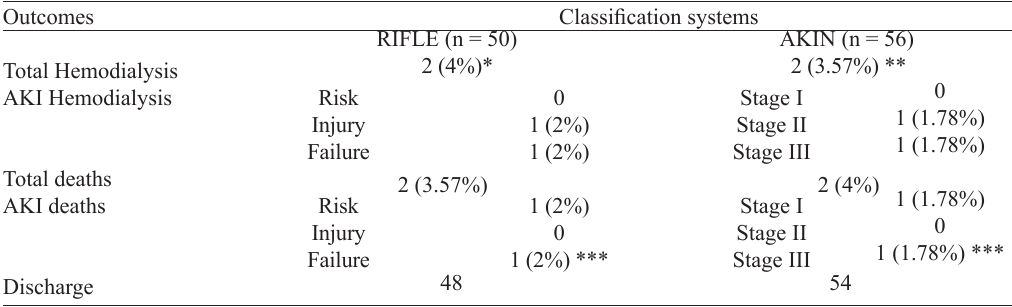
Table 5. Clinical outcomes stratified by the RIFLE and AKIN